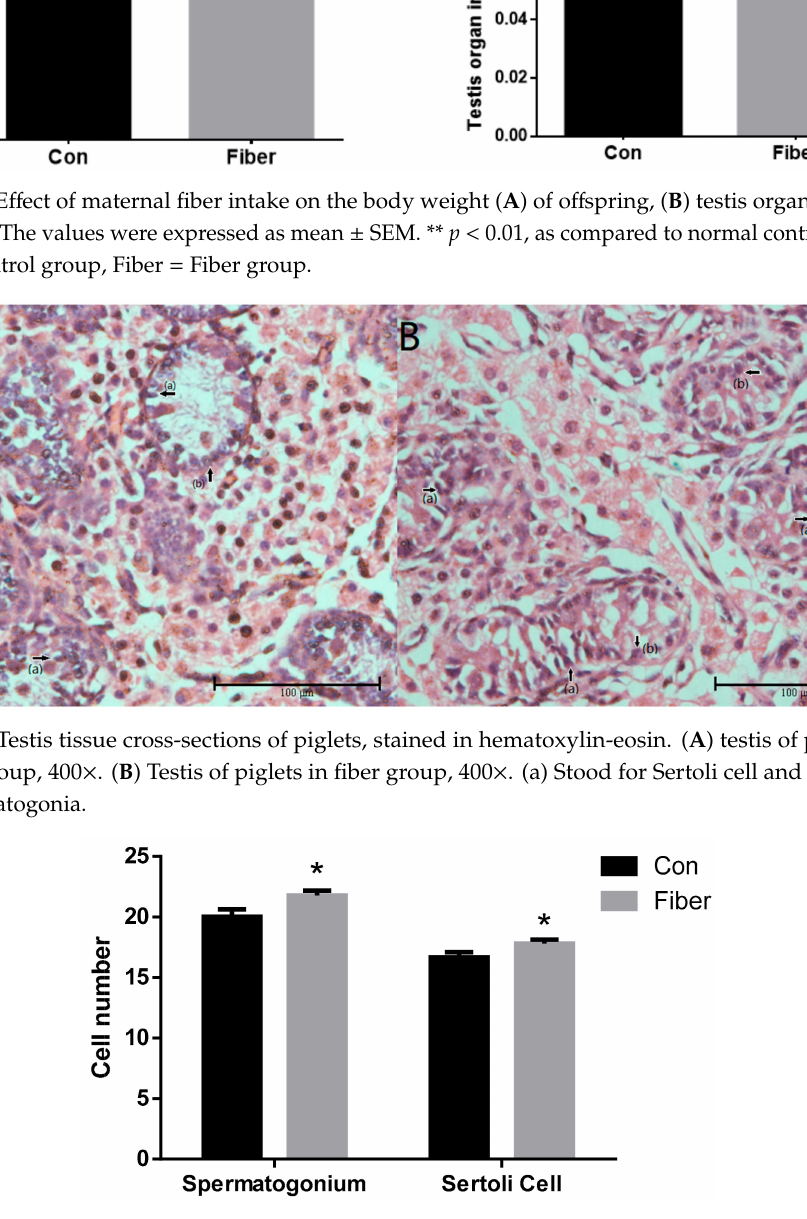
Figure 3. E ff ect of maternal fiber intake on the number of spermatogonium and Sertoli cells at per seminiferous tubule in testes of o ff spring. The values were expressed as mean ± SEM. * p < 0.05, as compared to normal control group. Con = control group, Fiber = Fiber